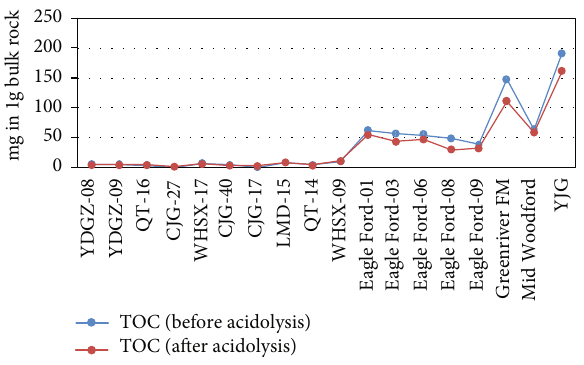
Figure 2: Comparison of TOC contents for rock samples before and after treating of acid.